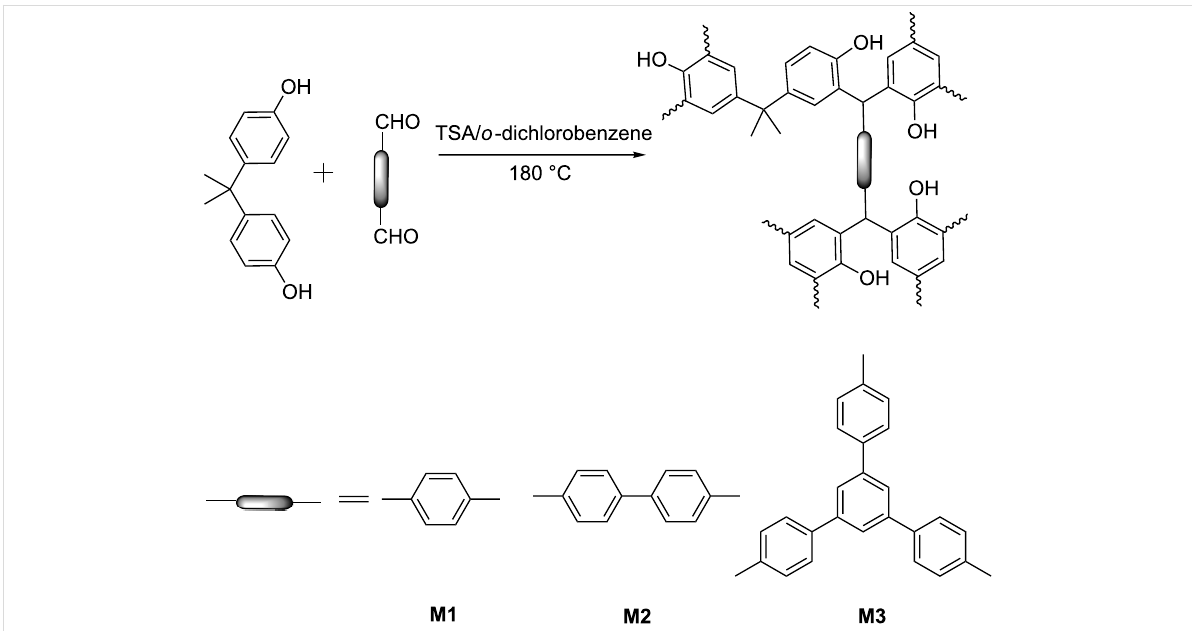
Scheme 1: Schematic representation of the possible structures of bisphenol-A-based porous organic polymers.